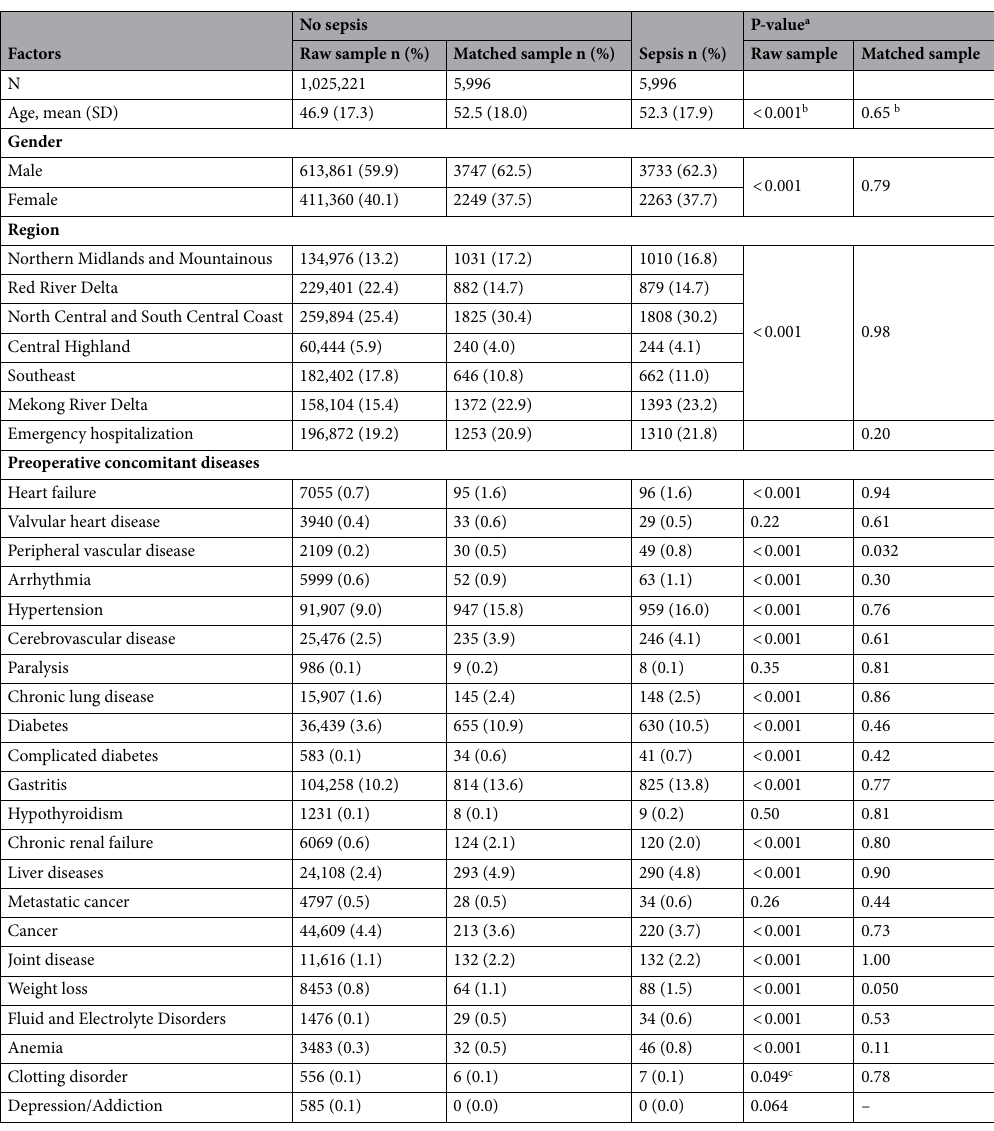
unless otherwise stated. b t test. c Fisher’s exact